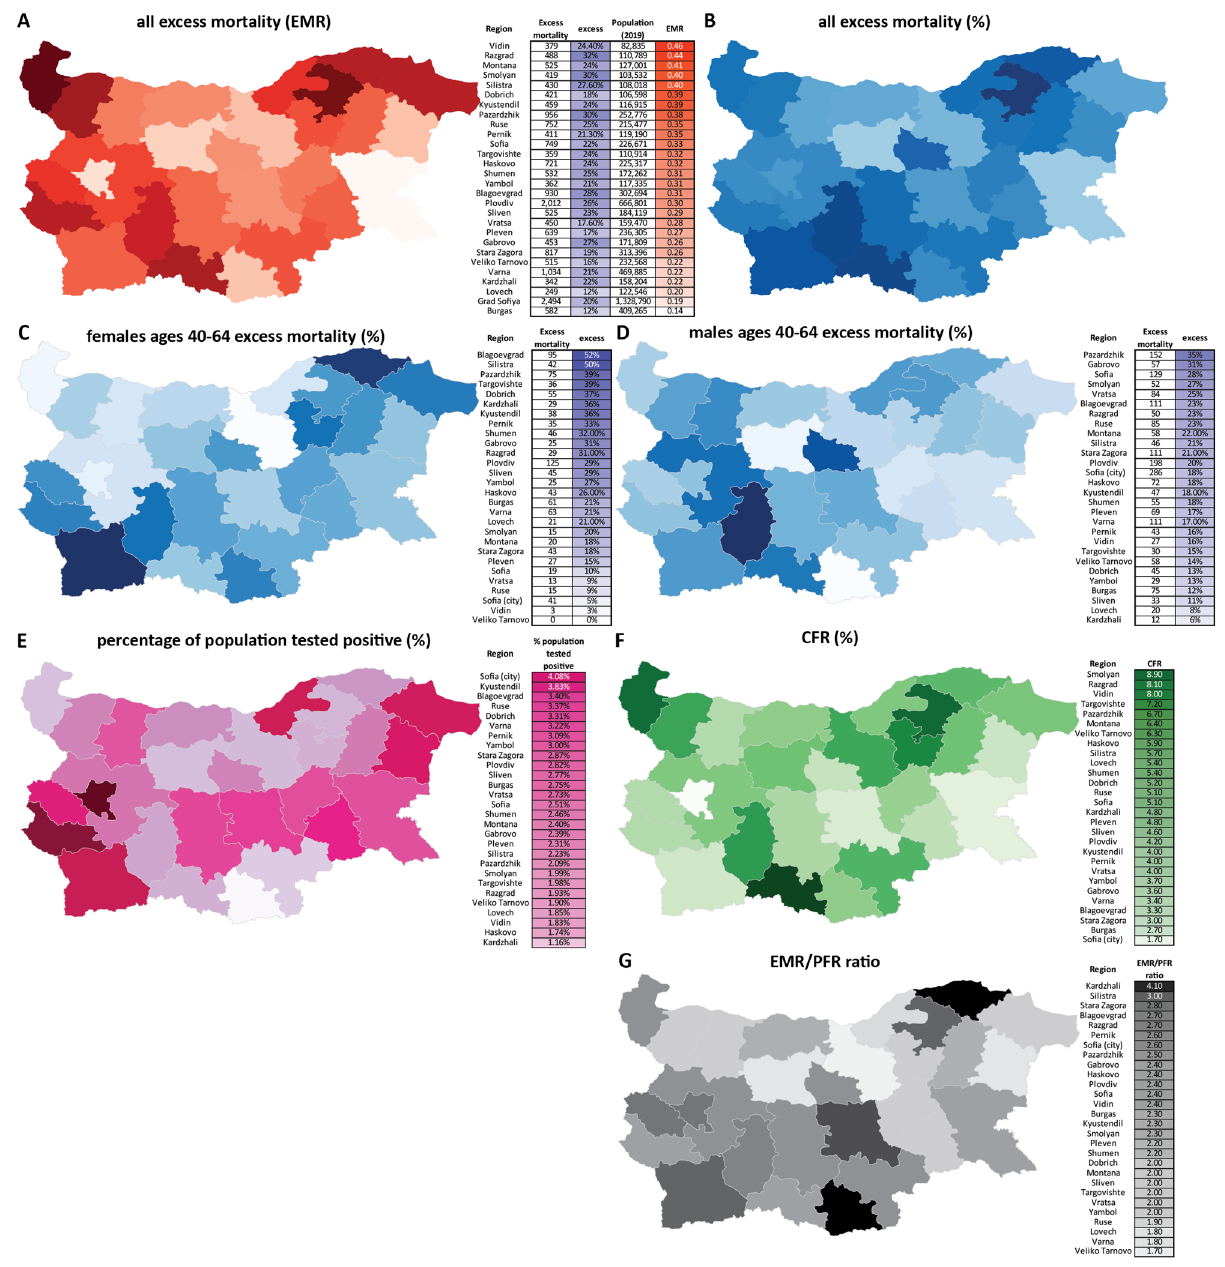
Figure 5. Regional disparities in the impacts of the COVID-19 pandemic in Bulgaria. ( A ) Overall excess mortality in Bulgarian regions (EMR units); ( B ) Overall excess mortality in Bulgarian regions (P-score); ( C ) Excess mortality in working age (40–64) females in Bulgarian regions (P-score); ( D ) Excess mortality in working age (40–64) males in Bulgarian regions (P-score); ( E ) Percentage of the population who have tested positive for SARS-CoV-2 in Bulgarian regions; ( F ) CFR values for Bulgarian regions; ( G ) Ratio between excess deaths (EMR) and official COVID-19-attributed deaths